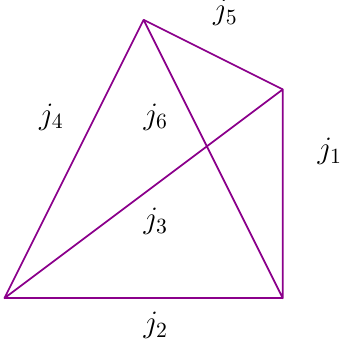
Figure 1. The labelling of the edges of the tetrahedron with irreducible